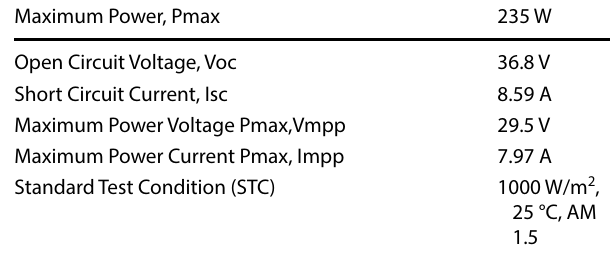
Table 1 Characteristics of PV